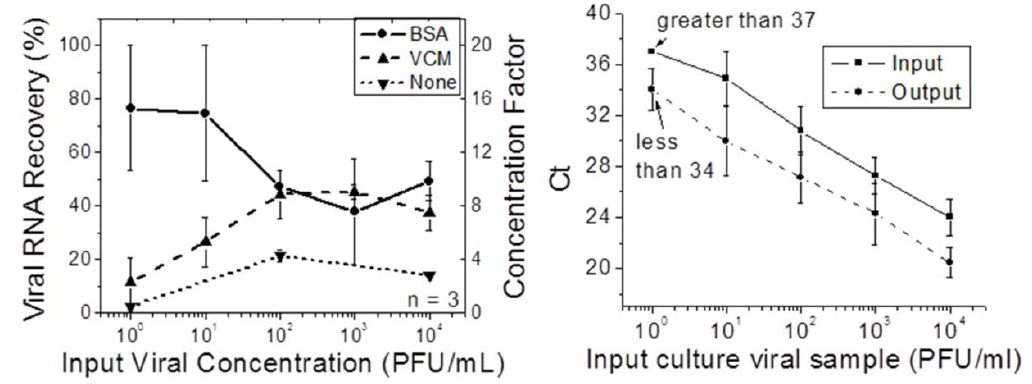
Figure 4. Left : Viral RNA recovery and concentration factor for different input (cultured) viral concentrations after chip surface treatment by BSA, viral culture medium (VCM), compared to non-treated chips. Right : Comparison of C cultured viral samples.